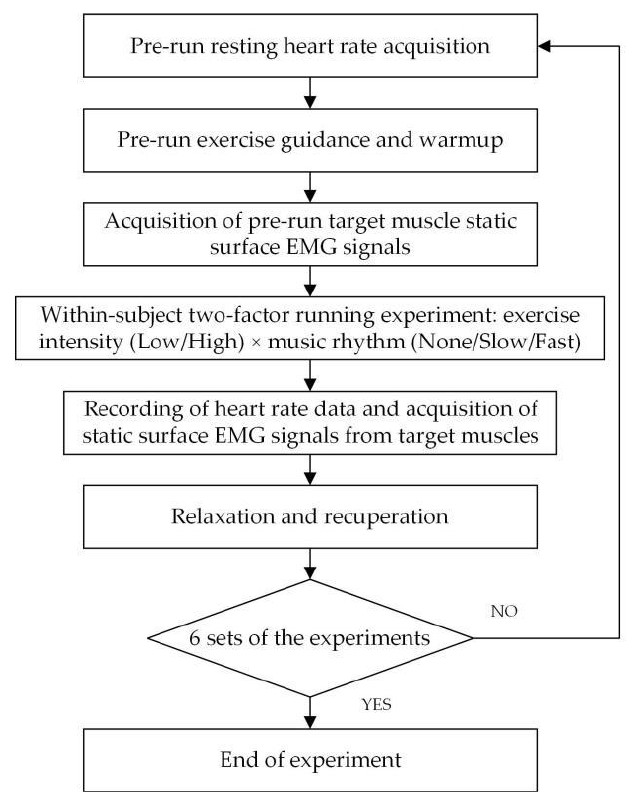
Figure 2. Experiment flow chart.